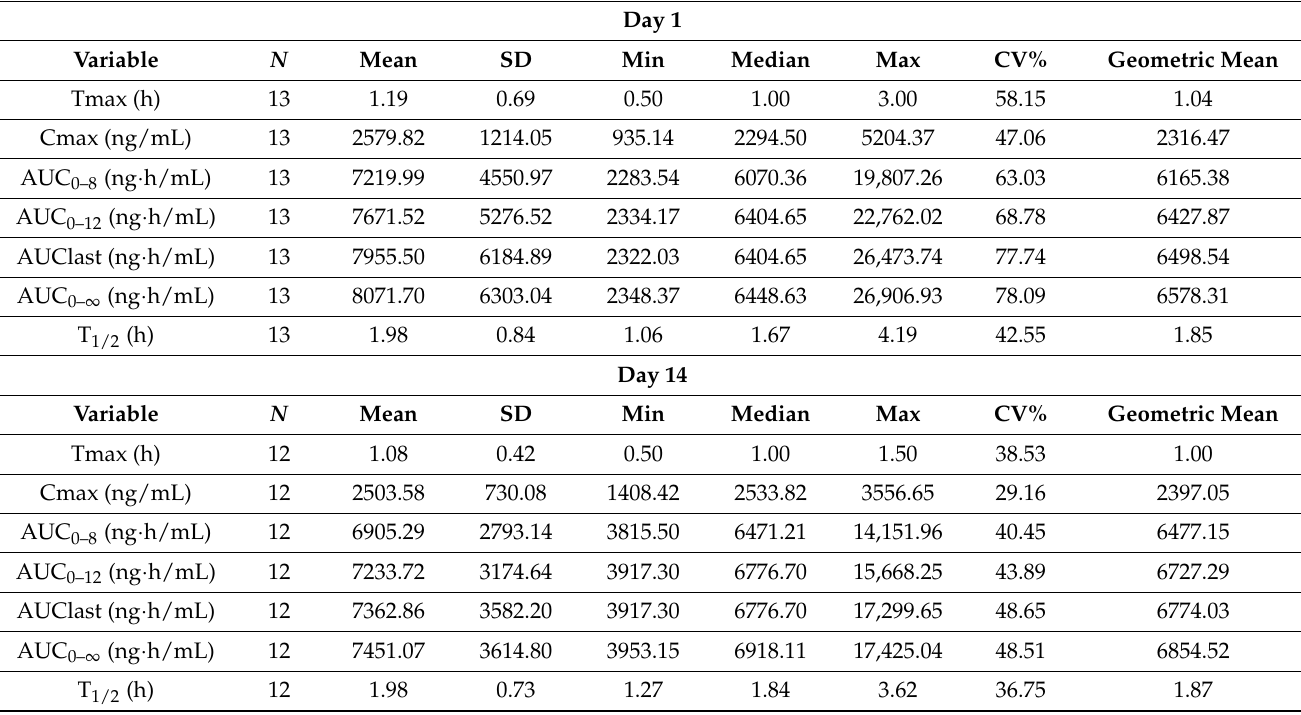
Table 2. Pharmacokinetic parameters of carisoprodol after single (350 mg) or multiple doses (up to 350 mg/8 h, 14